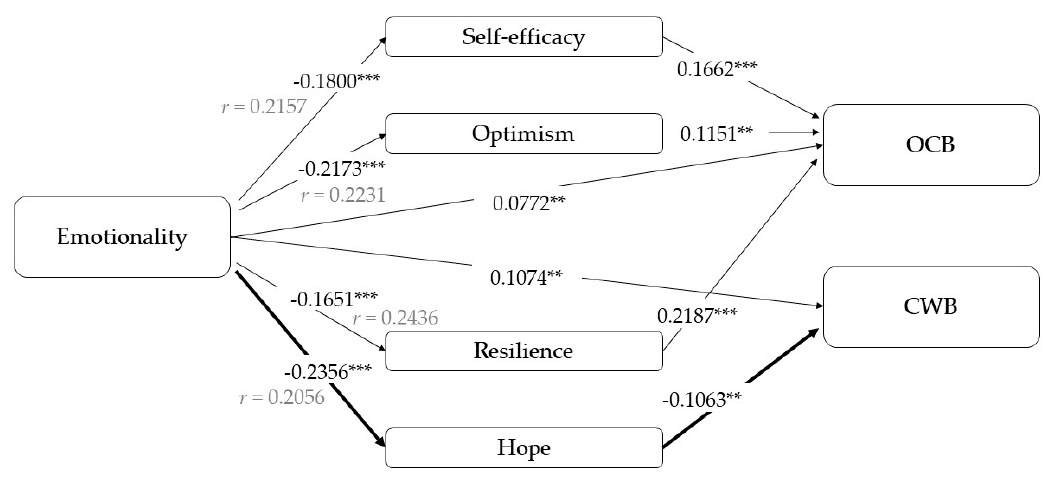
Figure 7. Results of the mediation models with emotionality as an independent variable. Note: [95% CI]; ** p < 0.01; *** p < 0.001.